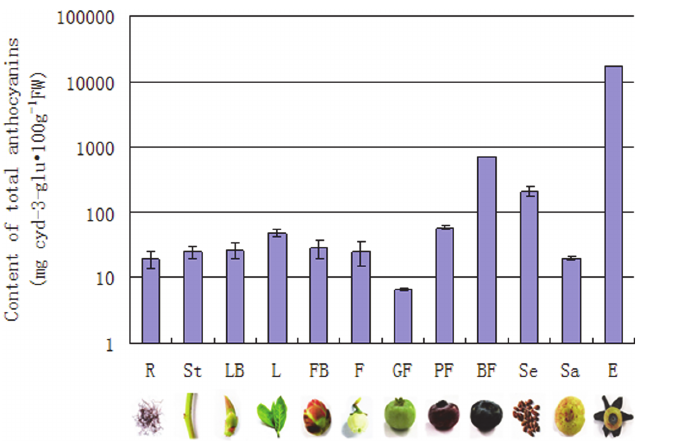
Fig 5. Anthocyanin content in different organs and developmental stages of fruit. The following 12 samples were analyzed: R-roots, S-stem, FB-flora buds, F-flowers, LB-leaf buds, L-young leaves, GF-green